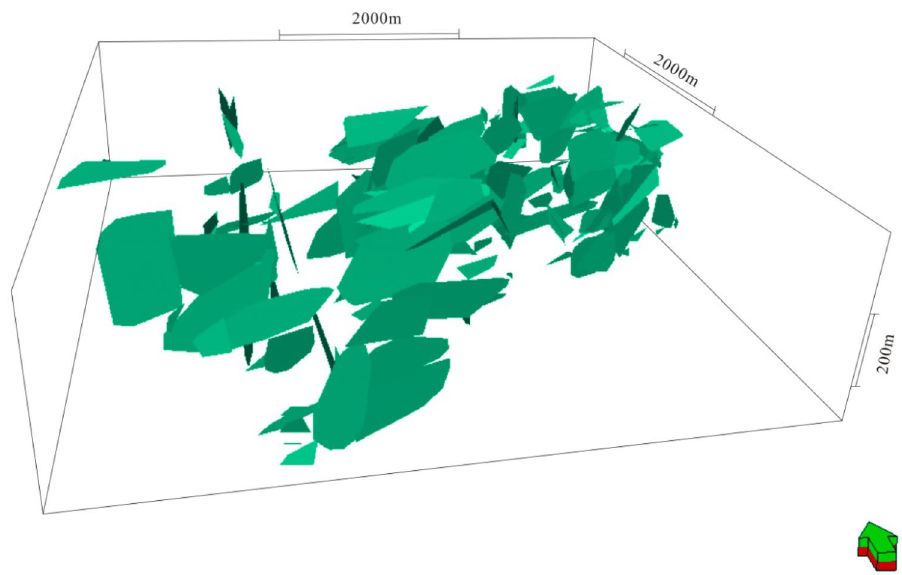
Fig. 8 Fracture model built by ant-tracking in Maxi